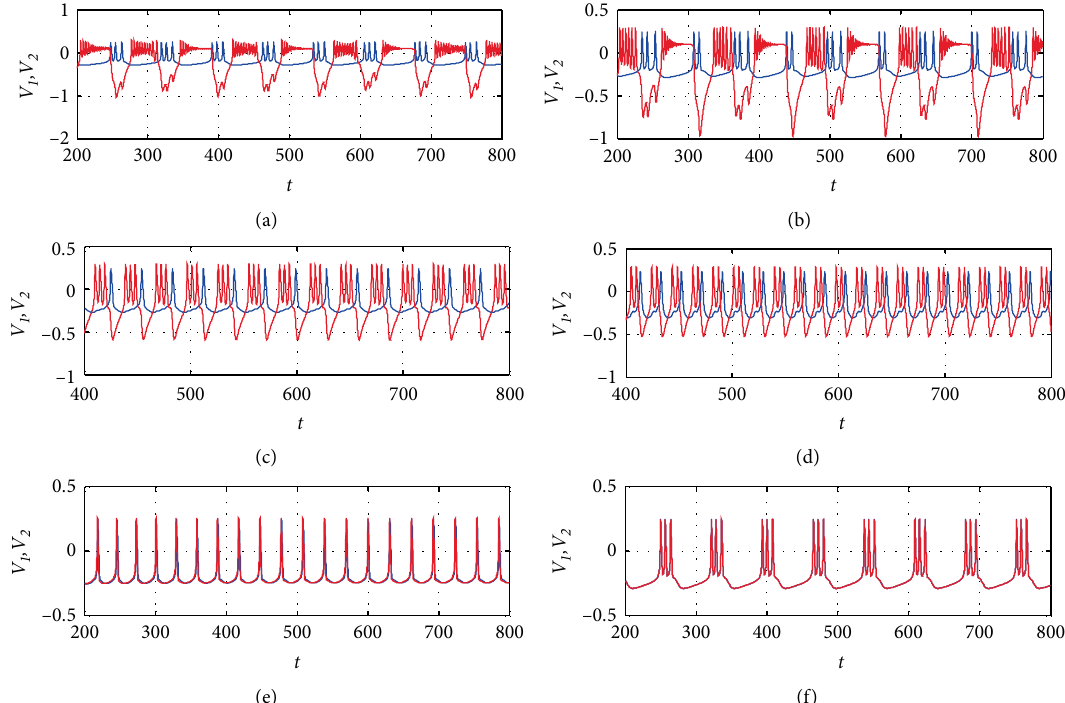
Figure 8: Synchronization transition of two identical coupled neurons with different coupling intensity values. (a) 𝑔 (c) 𝑔 , (d) 𝑔 , (e) 𝑔 , and (f) 𝑔 𝑠 = 0.025 𝑠 = 0.09 𝑠 = 0.31